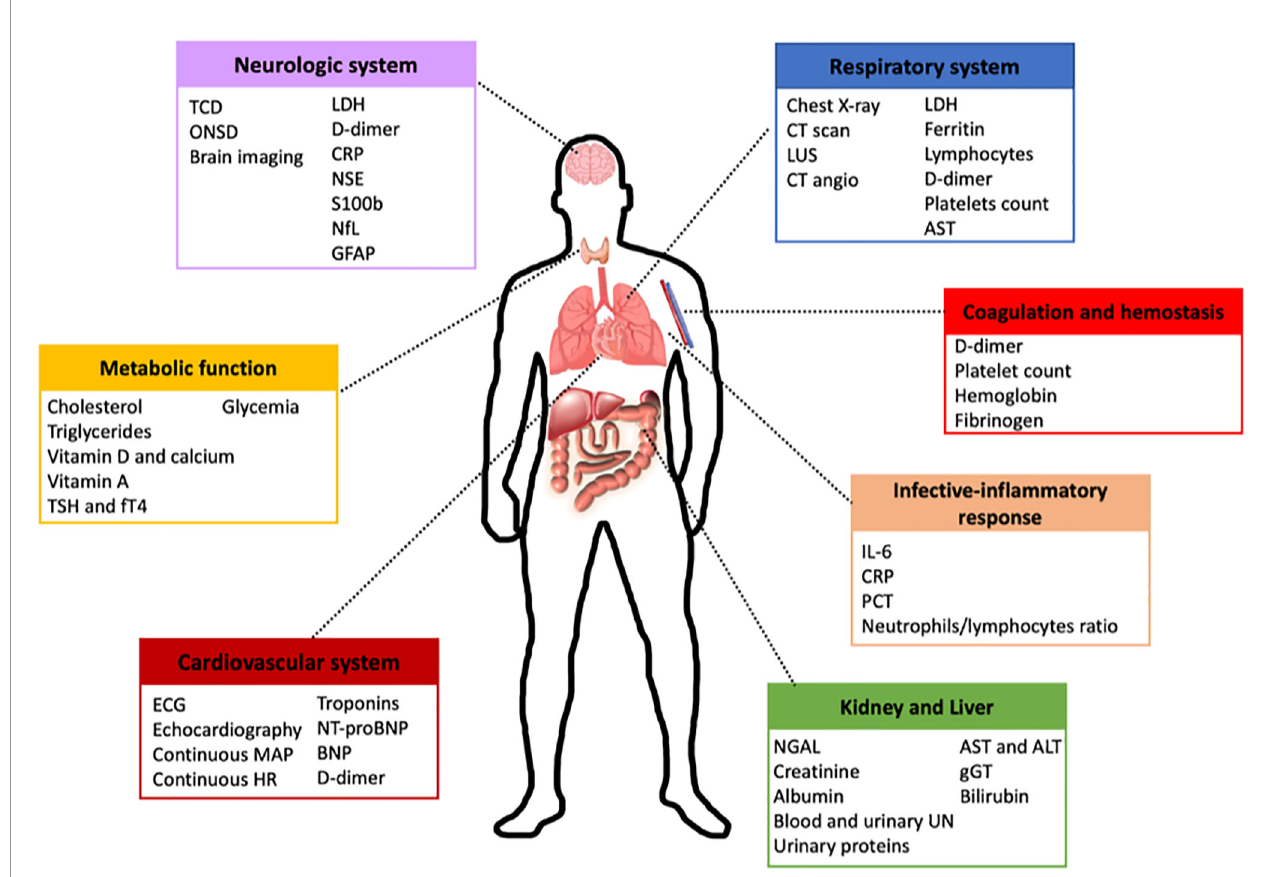
FIGURE 2 | Proposed algorithm for the management of patients with COVID-19 at ICU admission. This fi gure shows a potential algorithm for initial patient management at ICU admission, including the most useful biomarkers to be used in the COVID-19 critical care setting. Neurological system: sequential transcranial doppler (TCD) and/or optic nerve sheath diameter (ONSD) in sedated patients for whom conventional neurological evaluation is impossible. Cardiovascular system: electrocardiogram and echocardiography, as well as continuous monitoring of mean arterial pressure (MAP) and heart rate (HR), are suggested on ICU admission. Respiratory system: computed tomography (CT) scan is the gold standard; if not feasible, chest X-ray, CT angiography, and/or lung ultrasound should be performed. Lactate dehydrogenase (LDH), C-reactive protein (CRP), neuron speci fi c enolase (NSE), neuro fi lament light polypeptide (NfL), glial fi brillary acidic protein (GFAP), thyrotropic stimulating hormone (TSH), NGAL, aspartate transaminase (AST), alanine aminotransferase (ALT), gamma-glutamyl transferase ( g GT), interleukin-6 (IL-6). BNP, brain natriuretic peptide; UN, urea nitrogen; NT-proBNP, N-terminal